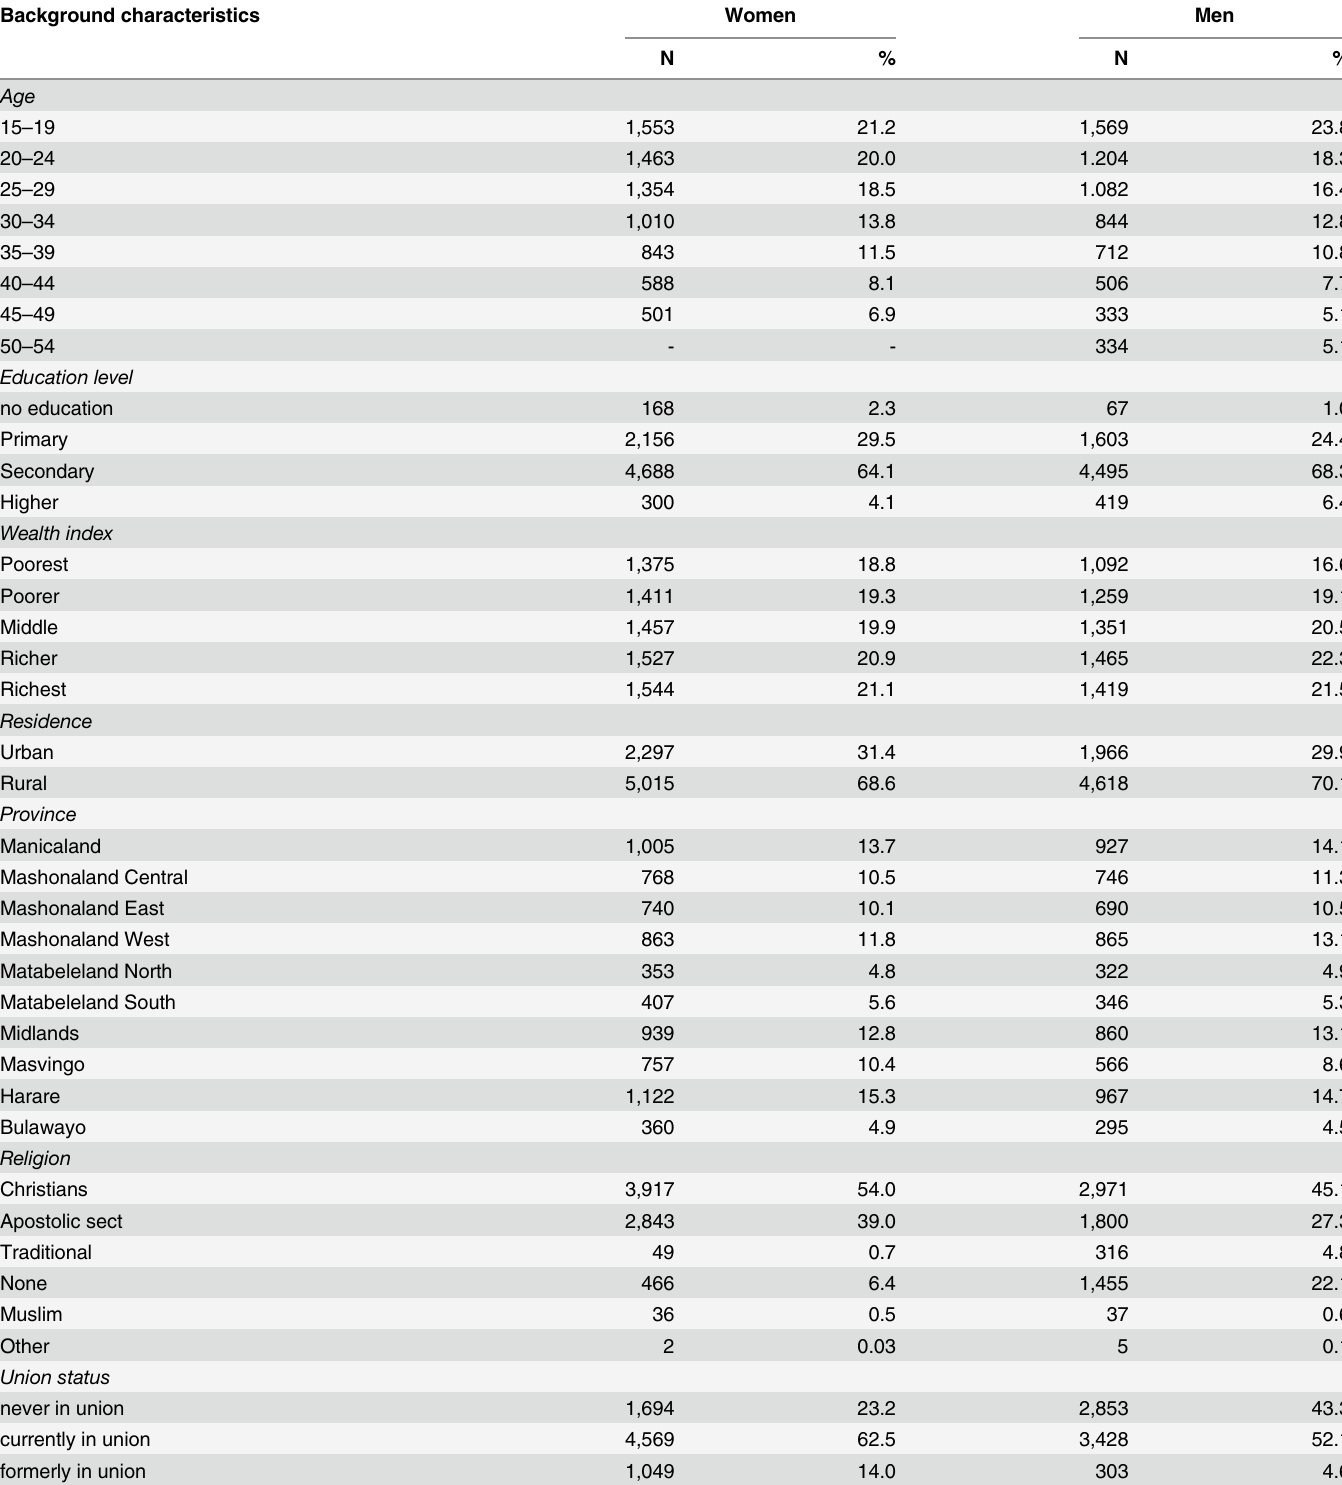
Table 1. Weighted numbers and percent distribution of socio-demographic and sexual risk characteristics among male and female respondents, ZDHS 2010 – 11. Background